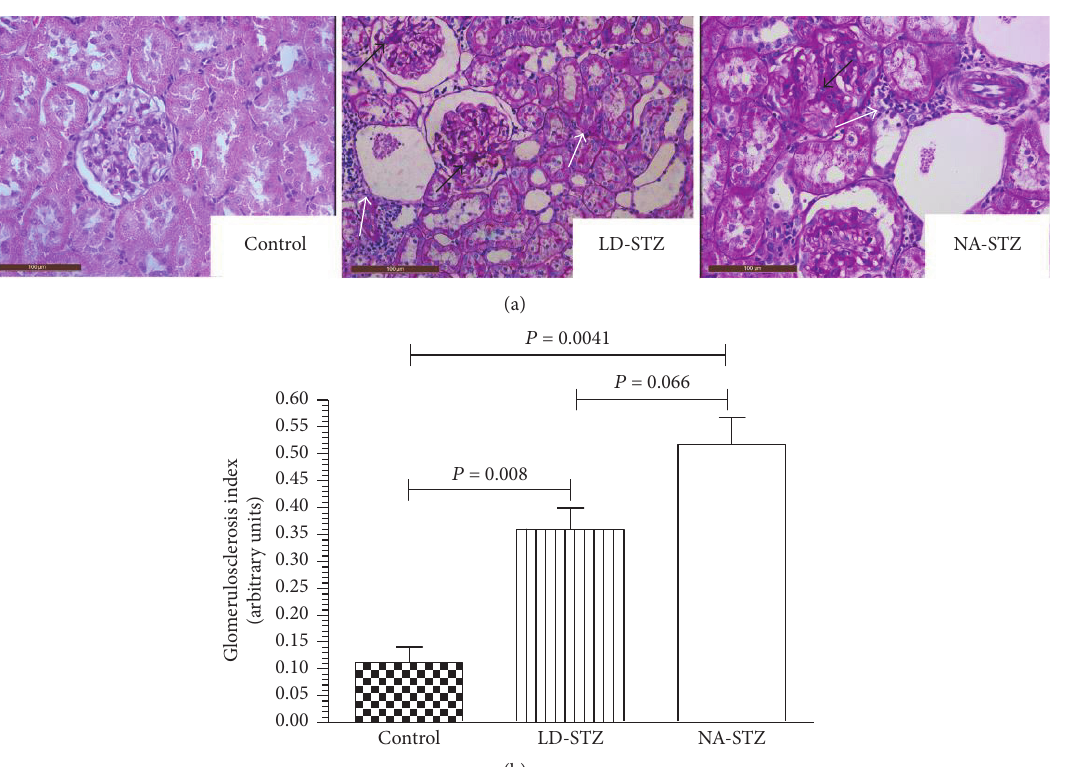
Figure 11: Glomerulosclerotic lesions in experimental groups at week 30. (a) Kidney sections were stained with periodic acid-Schiff reagent (magnification × 400). Representative microphotographs from two groups of diabetic rats show appearance of focal mesangial lesion with an acellular hyaline cores indicated by black arrows. Moreover, white arrows show interstitial inflammatory infiltration. Glomerulus from low-dose streptozotocin-induced diabetic rat demonstrates partial mesangiolysis and appearance of “lobular” structure of glomerular tuft. (b) Graphic representation of semiquantitative indices of glomerulosclerosis in the studied groups. Mean values and standard deviations are